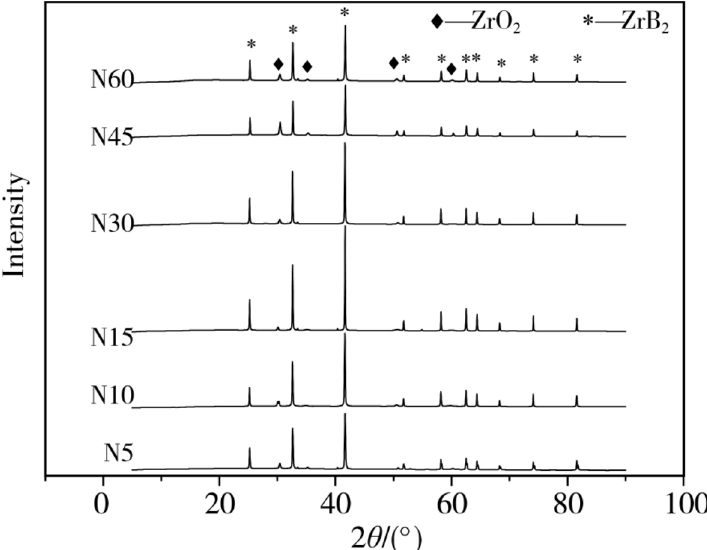
Figure 2. XRD patterns of ZrB 2 powders prepared with different content of NaB 4 O 7 [60].